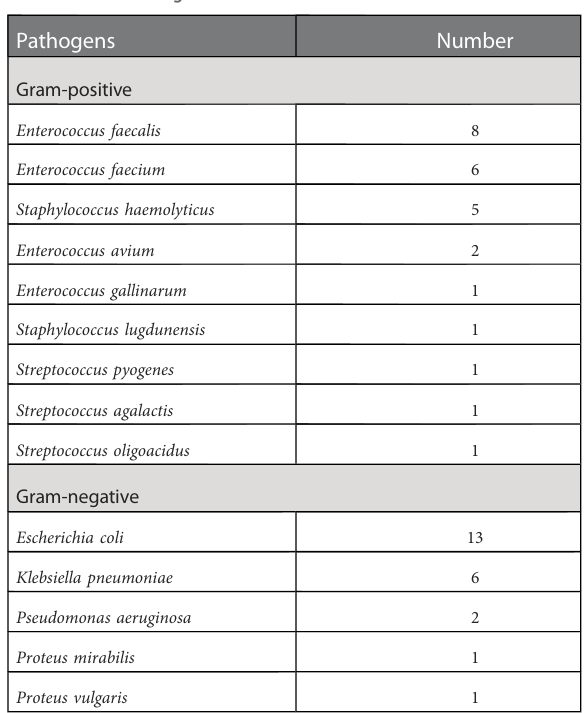
TABLE 1 Characteristics of patients and diseases. TABLE 2 Microbiological